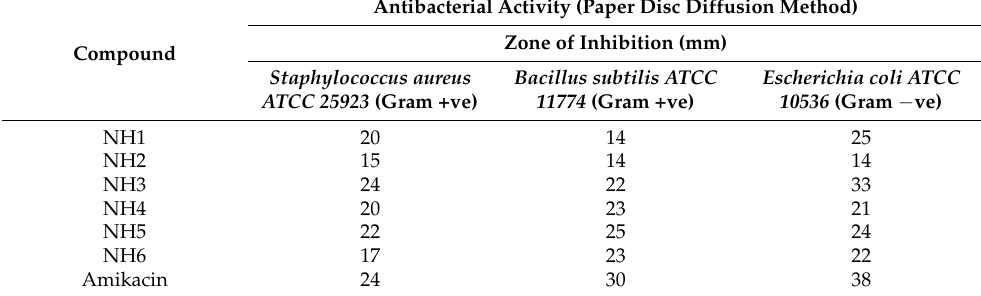
Table 2. Antibacterial activity via disc diffusion method.